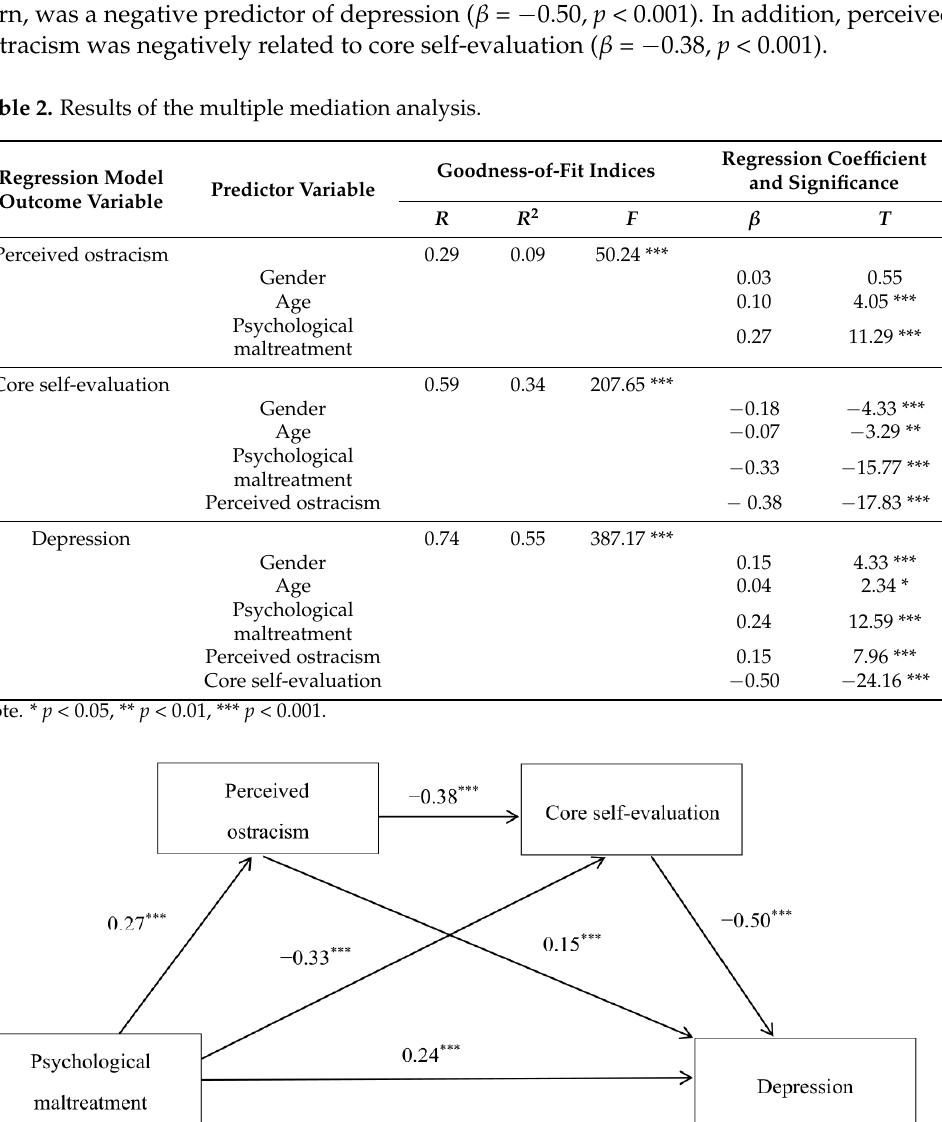
Table 3. Bootstrap analysis of multiple mediation effects.